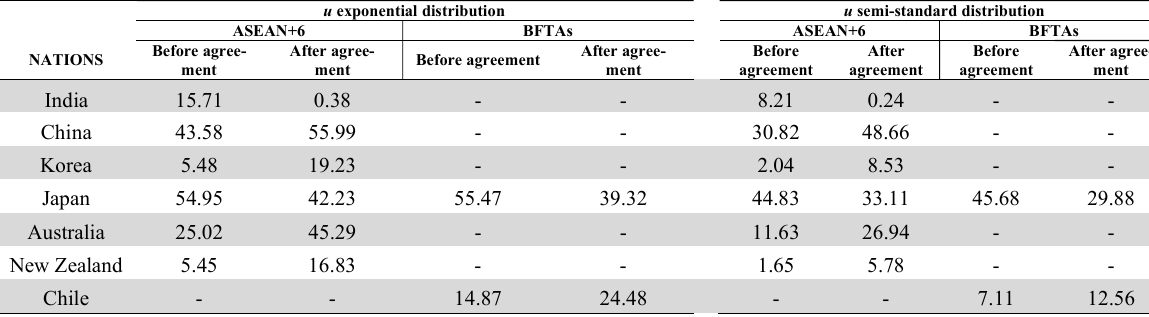
Exploiting the potential of rice export by country in the rice export